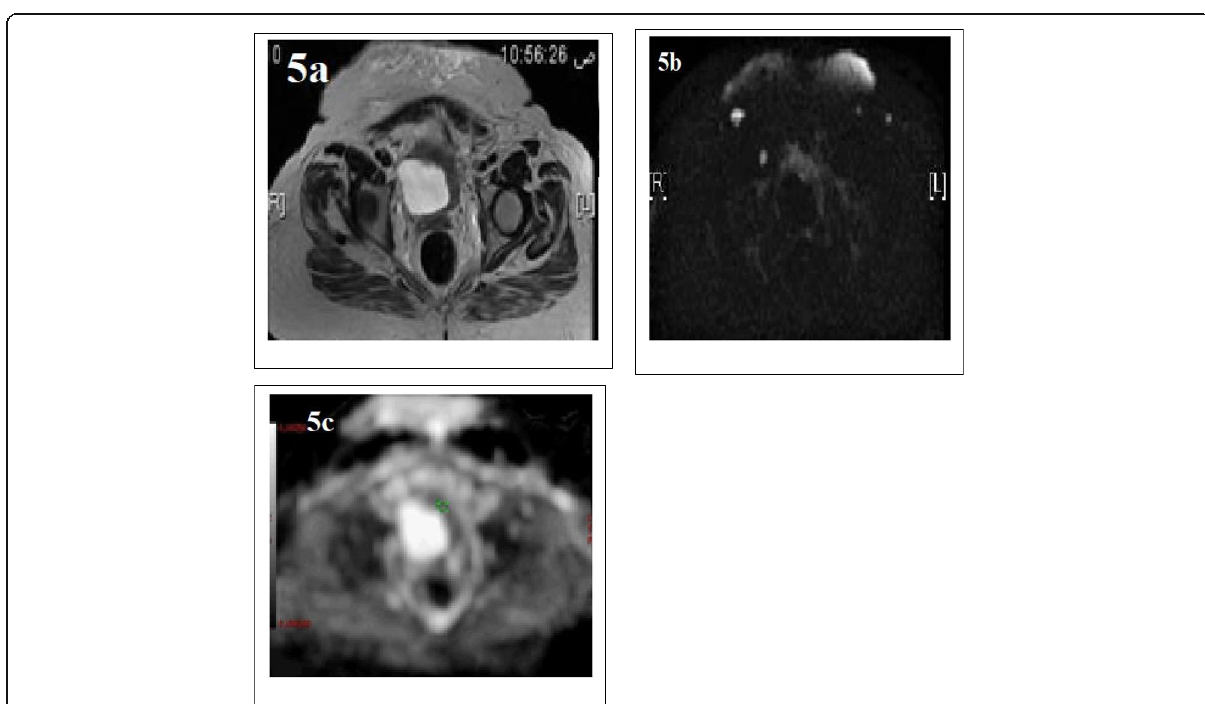
Fig. 5 Infiltrating papillary urothelial “ transitional ” cell carcinoma, stage T3 and grade 3, matching with T2WI ( a ) and DWI ( b ). The ADC value is towards the high-grade malignancy ( c ). The mean ADC = 1.13 × 10 − 3 mm 2 /s